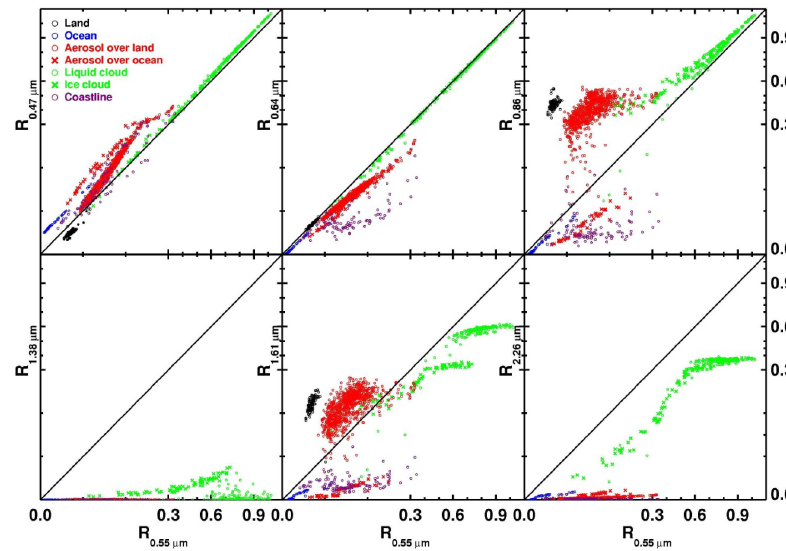
Figure 5b Fig. 5b. Same as in Fig. 6a, but on 8 July 2010.